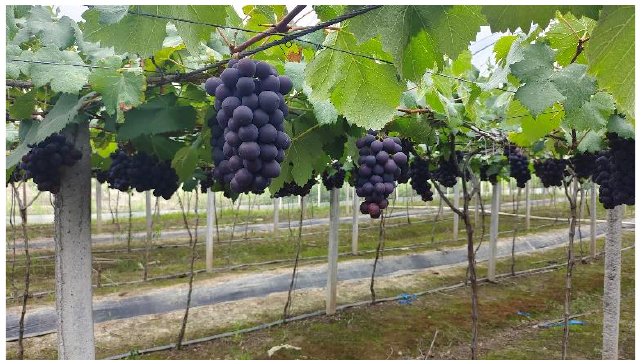
Figure 13. Image of grapes to be tested in the actual natural environment.